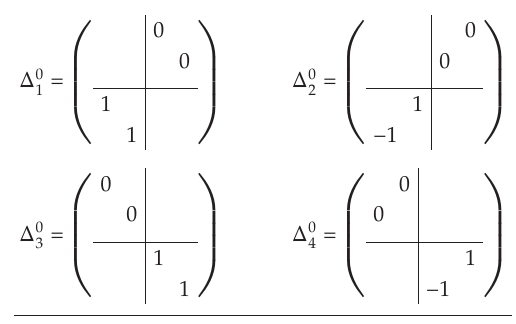
Table 5: The time-like dowm linkage matrices for the chiral multiplet. The fermion up matrices are deter- mined from these via (cid:6) u A (cid:7) d T A